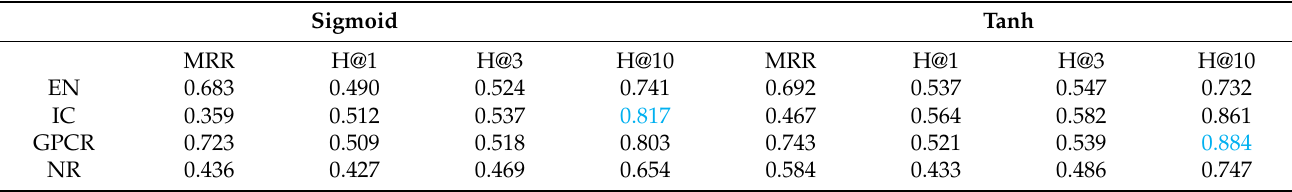
Table 3. The results of the optimization function.